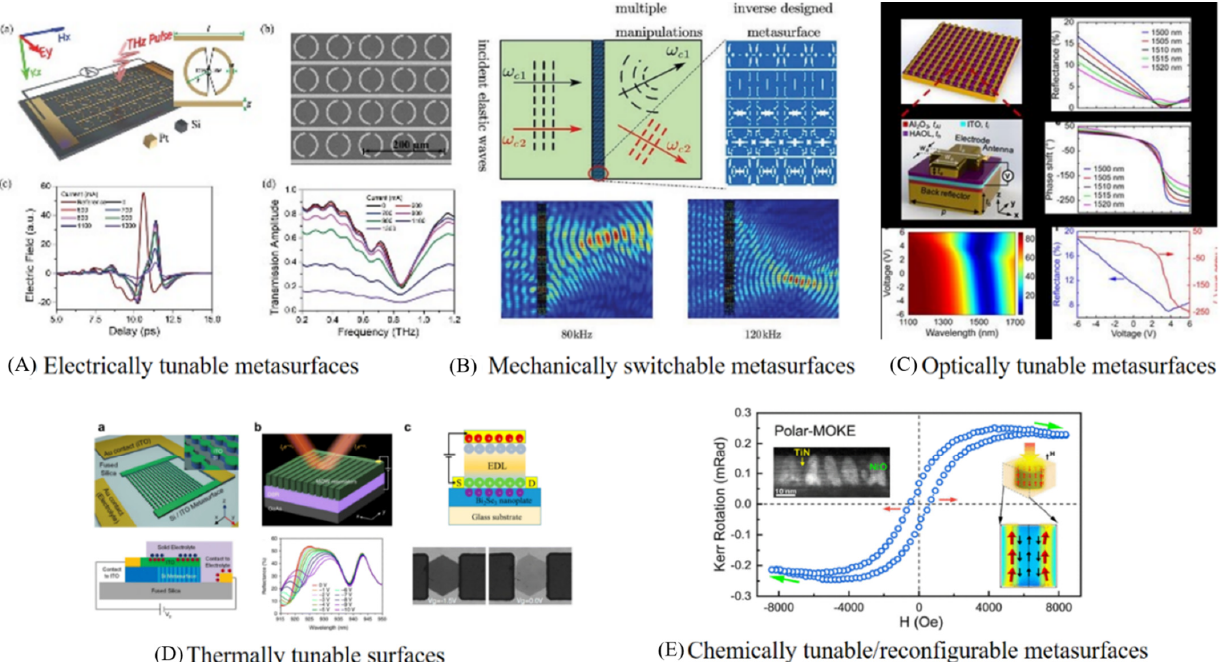
Figure 9. Reconfigurable and Tunable Metadevices ( A , B ) Reprinted with permission from John Wiley and Sons in Copyrights Clearance center, ( C ) Reprinted with permission from Copyright © 2020, American Chemical Society, ( D ) Reprinted with permission from Creative Commons Attribution 4.0 International License, ( E ) Reprinted with permission from Copyright © 2020, American Chemical Society.